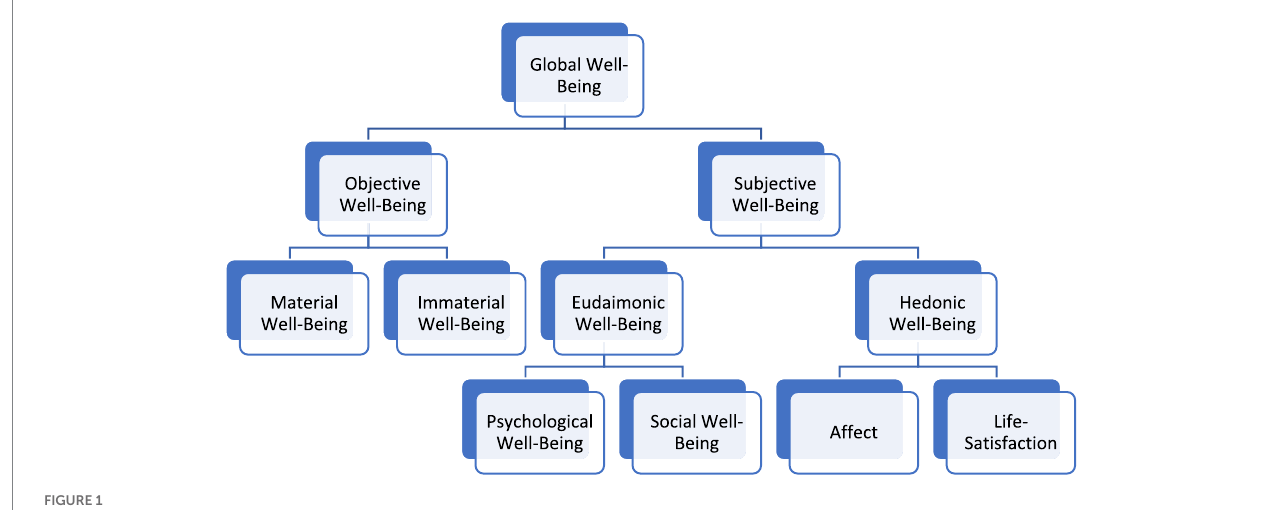
FIGURE 1 A summary of the various dimensions of well-being.